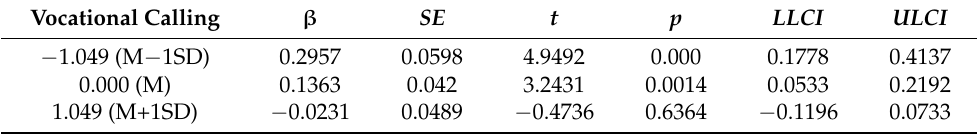
Table 6. Conditional effect of servant leadership according to vocational